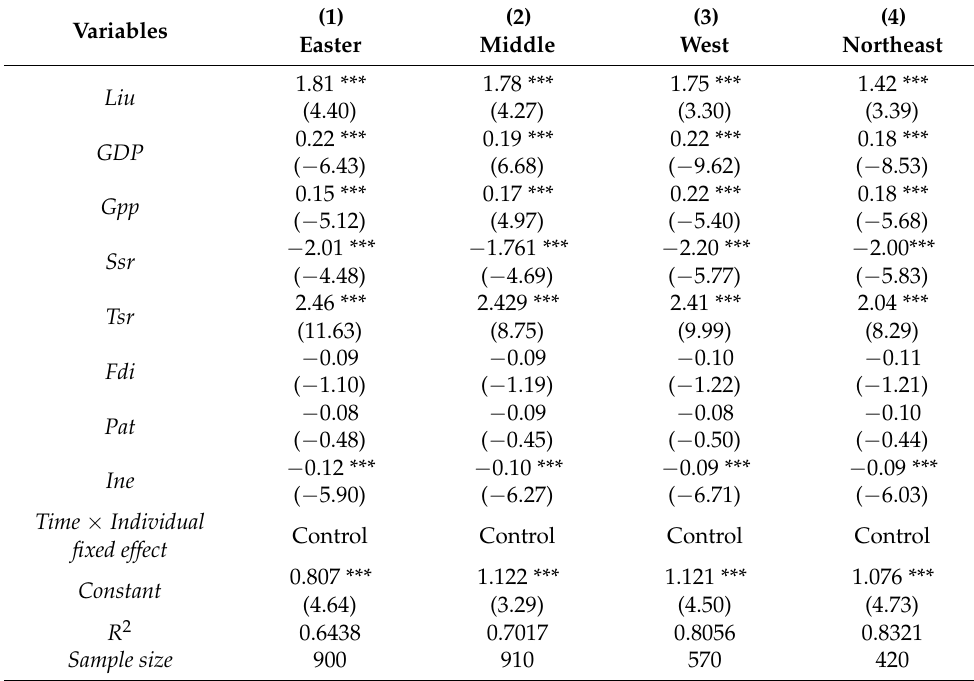
Table 3. Benchmark regression results of four regions in